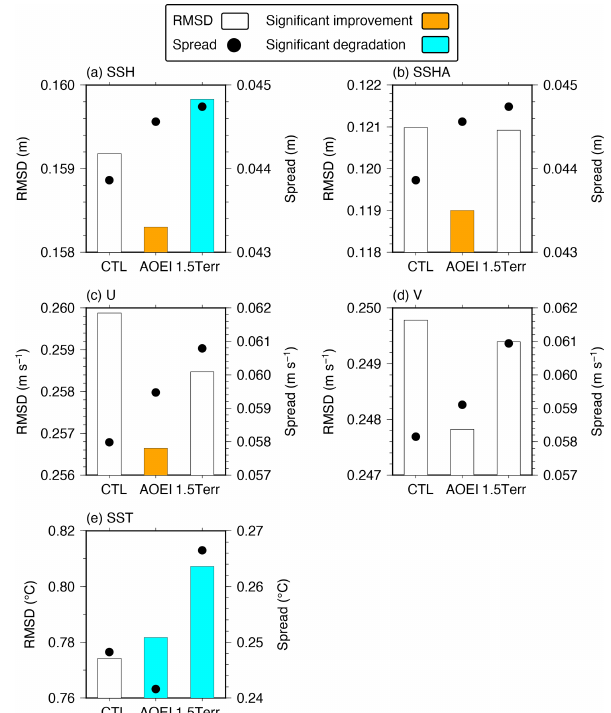
Figure 13. RMSDs of the CTL, AOEI, and 1.5Terr runs relative to (a) SSH and (b) SSHA datasets from the AVISO, relative to in situ surface (c) zonal and (d) meridional velocity from drifter buoys, and relative to (e) Himawari-8 SSTs averaged over the whole do- main and period. Black dots indicate the ensemble spread in the observation space. We note that the ranges of the vertical axis are different between the RMSDs and ensemble